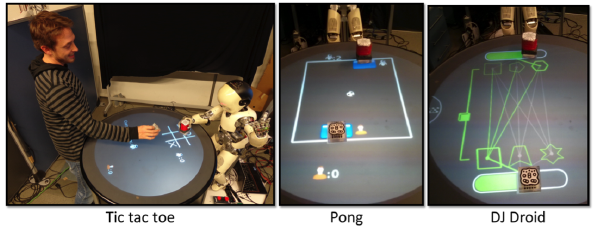
Figure 7: Examples of different Reactable applications implemented for the H5W_Alpha agent. Tic Tac Toe demonstrates long-term mem- ory and extraction of strategy, Pong is all about motor-control and anticipatory movements, and finally the DJ Droid emphasizes rein- forcement learning and artistic